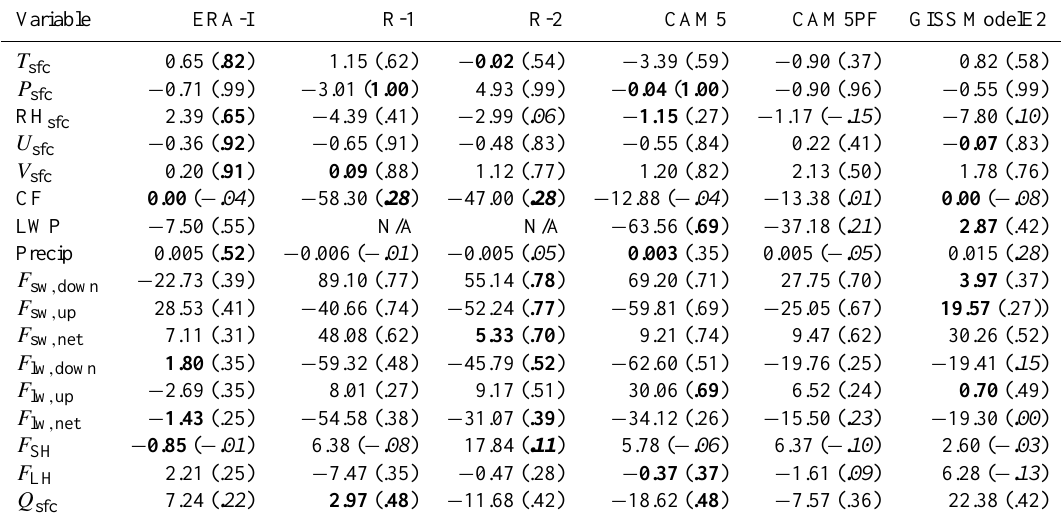
Table 1. Median biases and correlation (in parentheses) to observations for each of the evaluated variables. Italicized correlations are not statistically significant at the 95% level. The best performing statistics for each variable are included in bold.